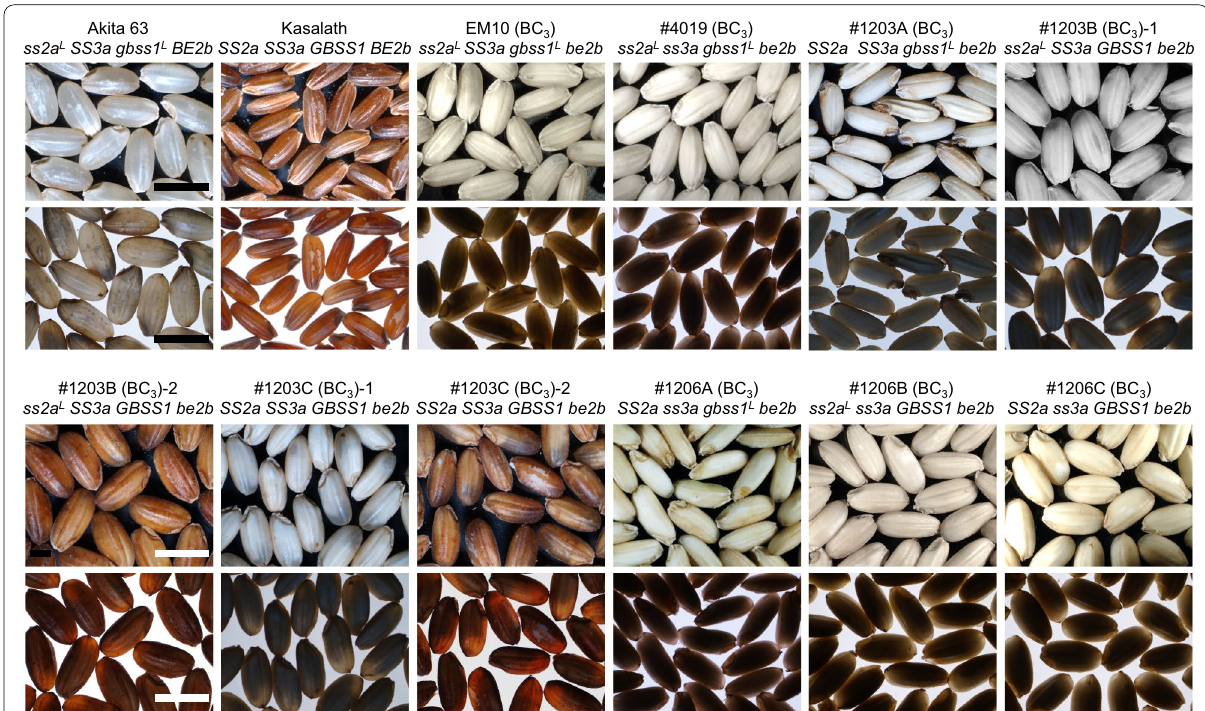
Fig. 2 Morphology of dehulled mature seeds. Photos of seeds of different rice lines captured using light from above (upper panels) and below (lower panels). Scale bars: 5